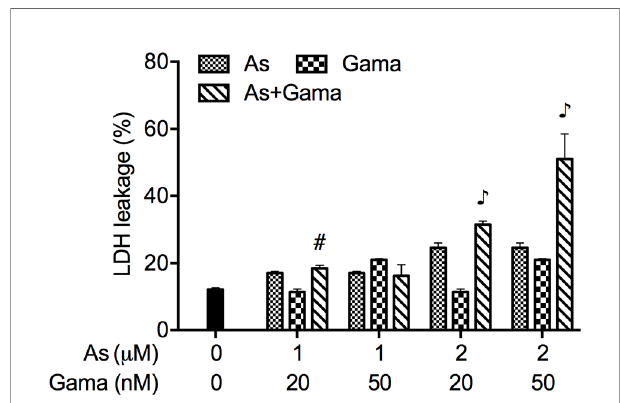
FIGURE 5 | Enhanced LDH release in U-87 cells treated with relatively low concentrations of As III combined with gamabufotalin. Following treatment for 48 h with As III (1 and 2 µM) and gamabufotalin (20 and 50 nM), alone or in combination, LDH leakage was measured using the LDH-Cytotoxic test kit as described under Materials and methods. Results are shown as the means ± SD (n ≥ 3). # p < 0.01; ♪ p < 0.0001 vs. each alone. As, As III ; Gama, gamabufotalin.